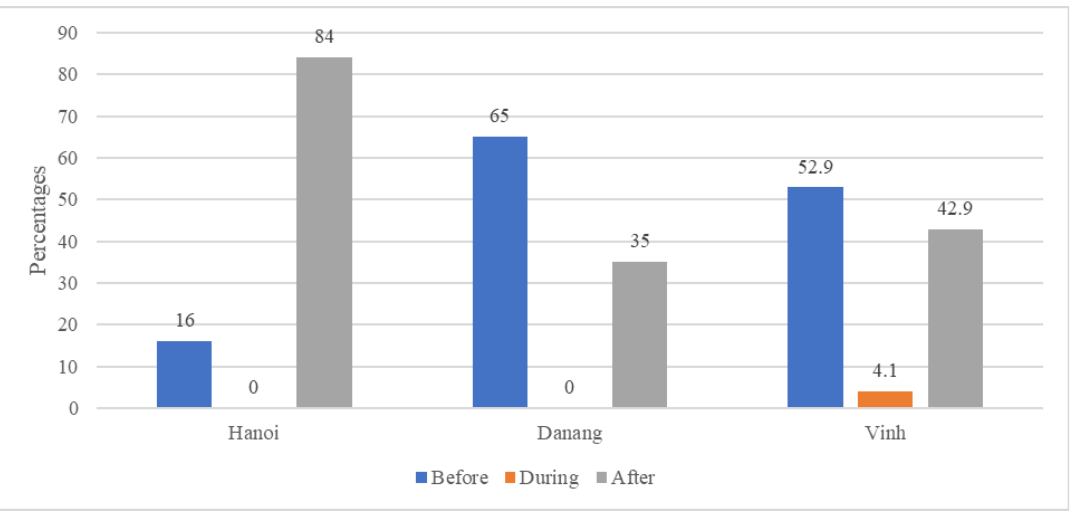
Figure 6. Life choices of surveyed households in the time before, during, or after land acquisition. Source: Households survey, 2019 and 2020.